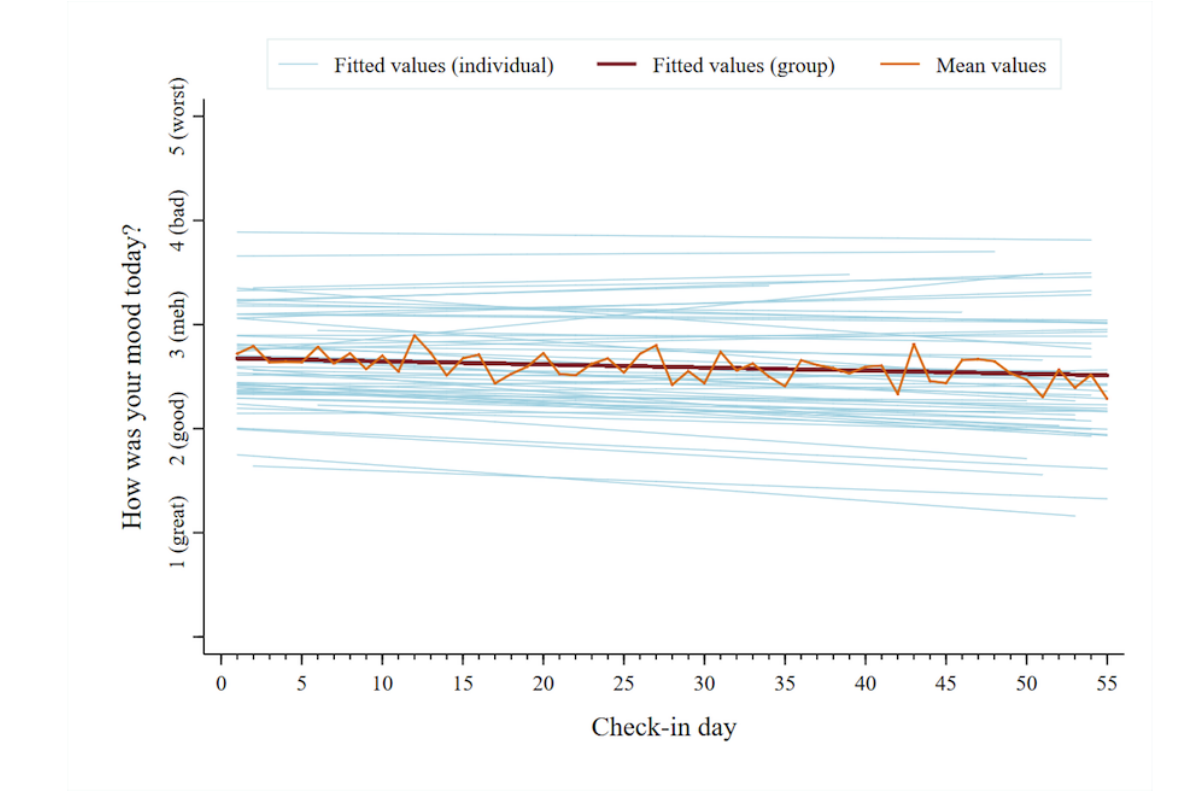
Figure 7. Self-reported mood across 55 days using the iCanCope daily Check-in.